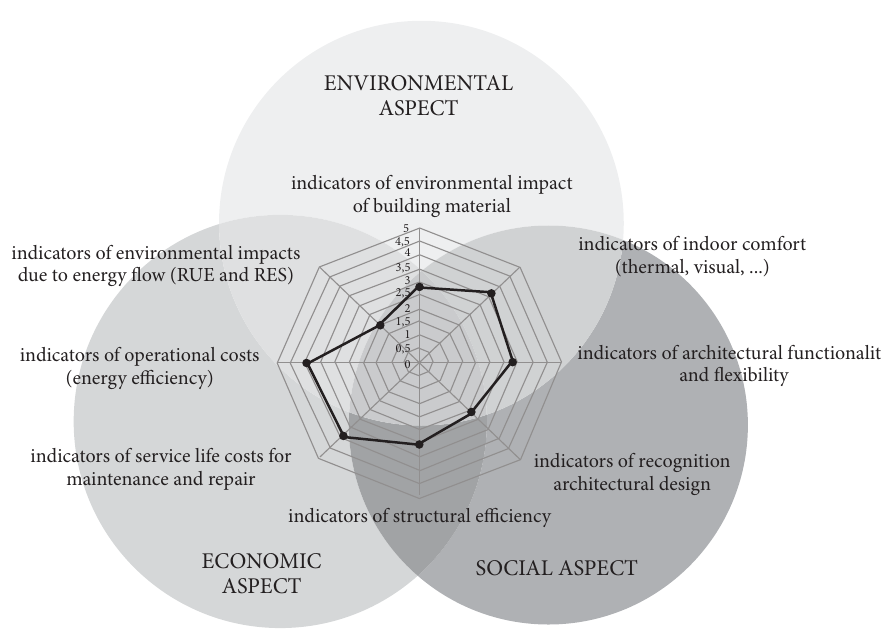
Fig. 4. Aggregated indicators of apartment building sustainability and their reference to the environmental, economic and social aspect of sustainability as obtained for a selected residential